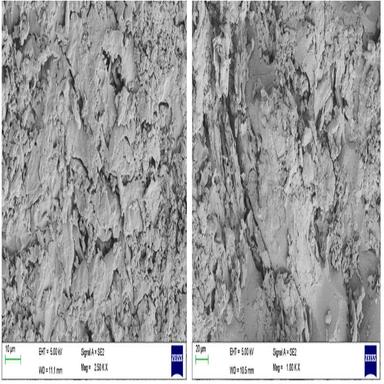
SEM of the fracture surface of Citrus limetta peel powder composites.